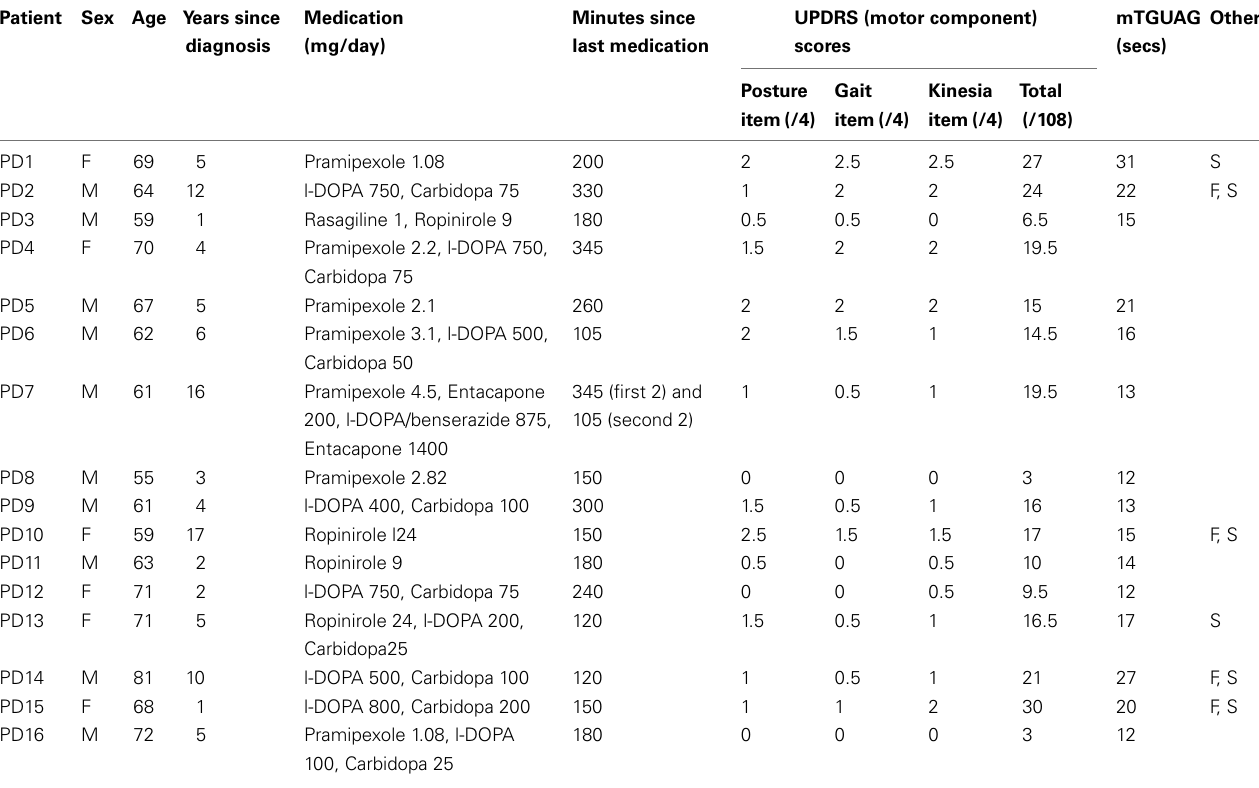
Table 1 | Clinical details of the patients with Parkinson’s disease who participated in Experiment